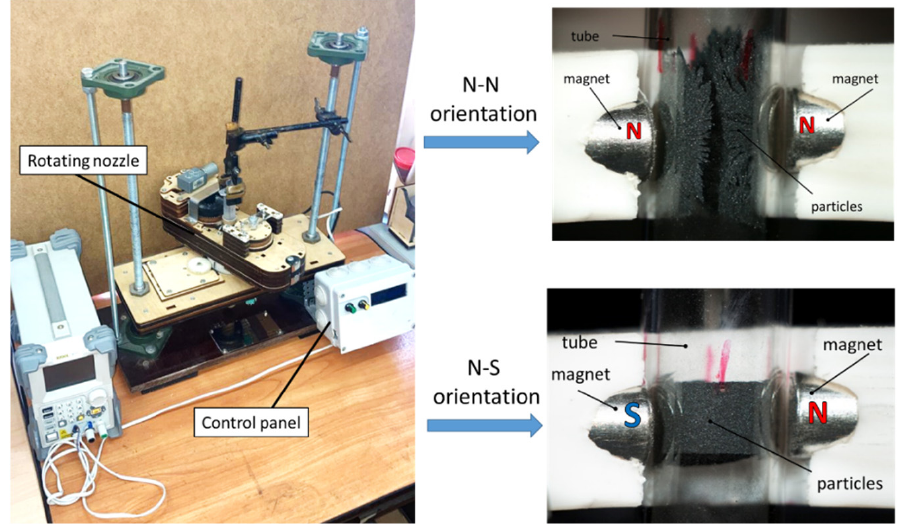
Figure 2. RMF setup with different permanents magnets orientation and particle structure.